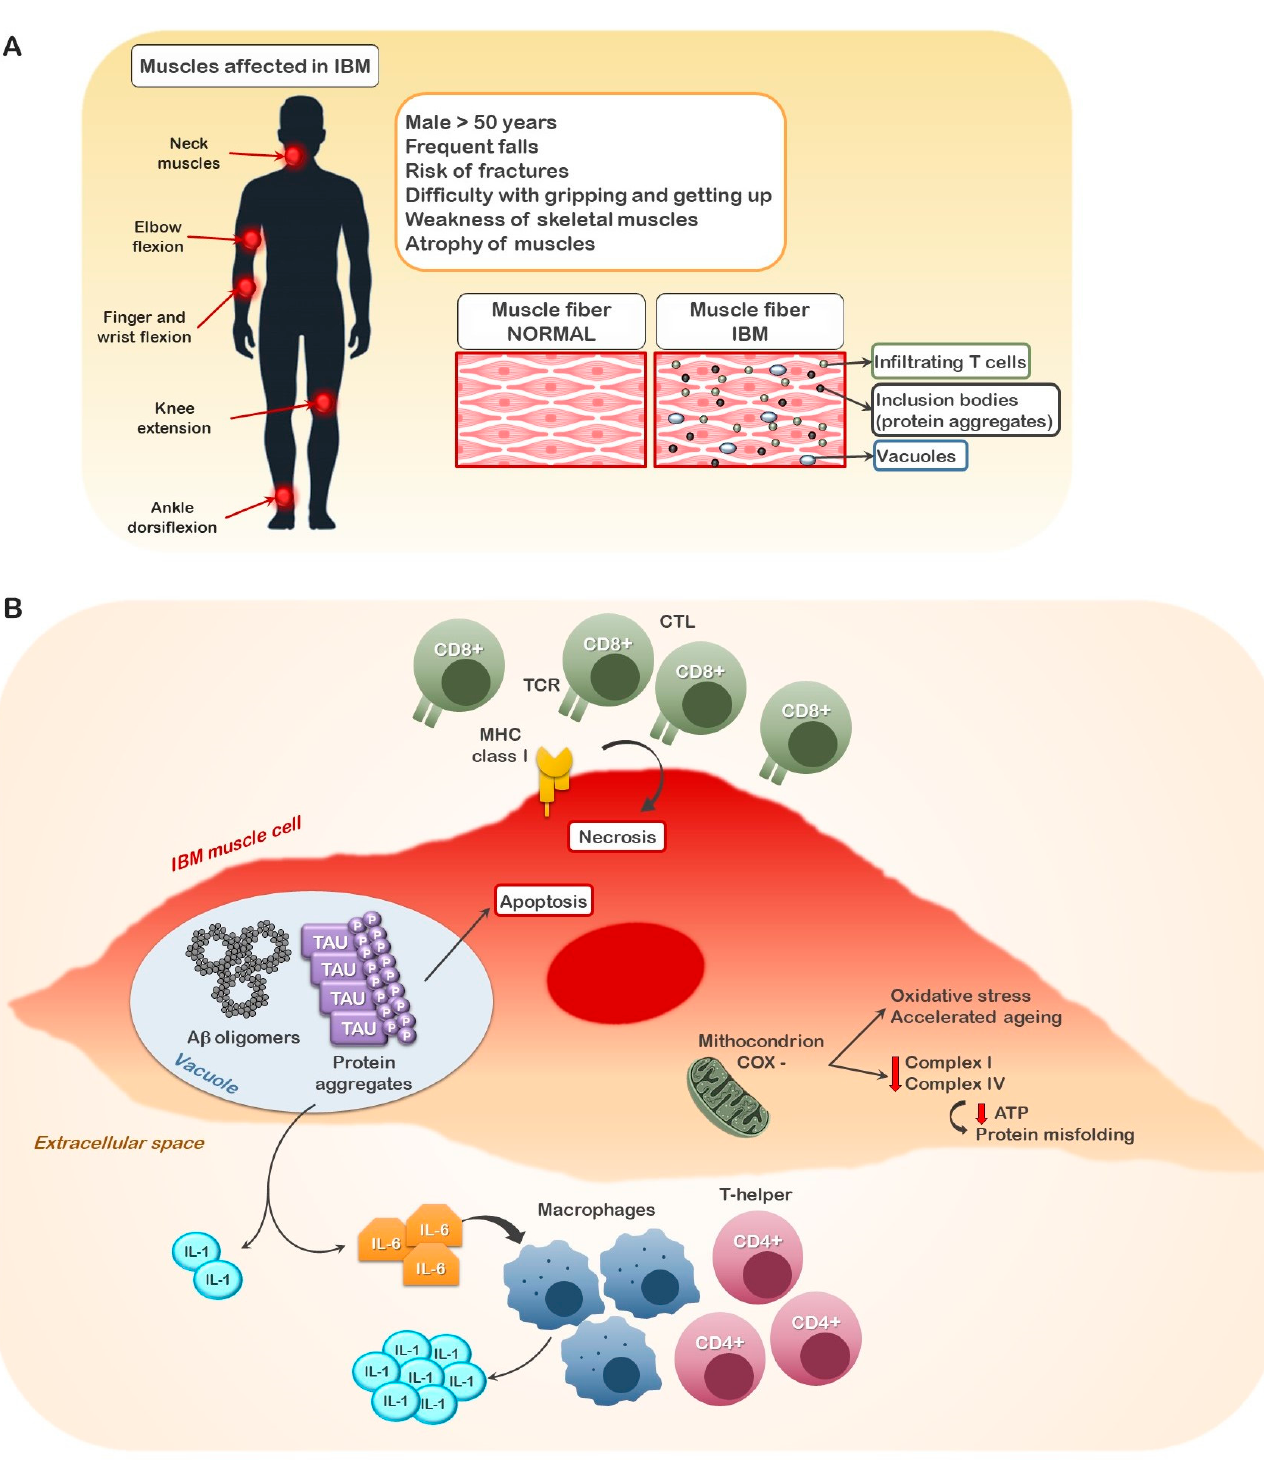
Figure 1. Physical and cellular manifestations of IBM. ( A ) A schematic diagram of physical and histopathological manifestations in IBM patients from early onset to late disease. ( B ) Schematic diagram of cellular and molecular findings in muscle biopsies from IBM patients.